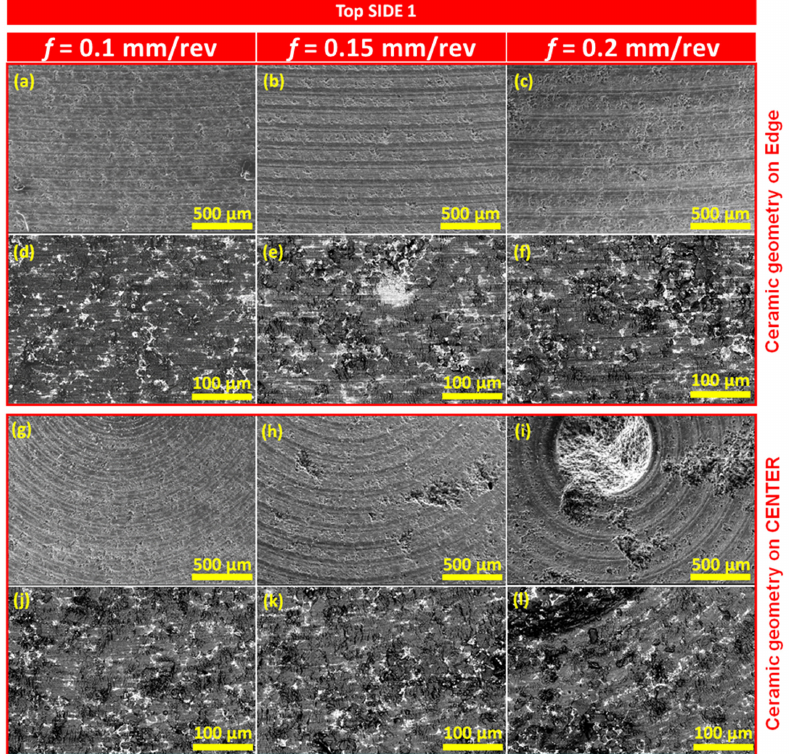
Figure 10. SEM analysis of the top side where pressure was applied during green compact processing indicating the variation in the turning characteristics of ZnO varistors for different feed rates (hori- zontally). SE imaging of the topographical contrast of the surface features after turning in the edges shown from ( a – c ) with an increasing feed velocity. BSE phase contrast imaging of the edge region is depicted by ( d – f ) with horizontal increases in the feed velocity. The topographical SE imaging in the center of the ZnO varistor is shown for consecutive increases in feed velocities by ( g – i ) at 100 × magnification, whereas the phase contrast imaging of the central segment of the ceramic is demonstrated from ( j – l ) at 500 ×